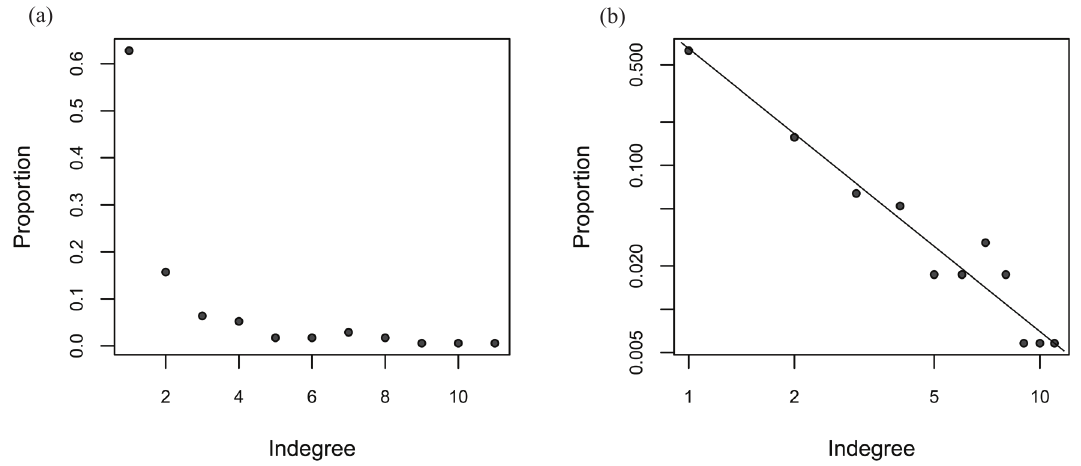
Fig. 5. Distribution of indegree proportion (a), log-log space transformation